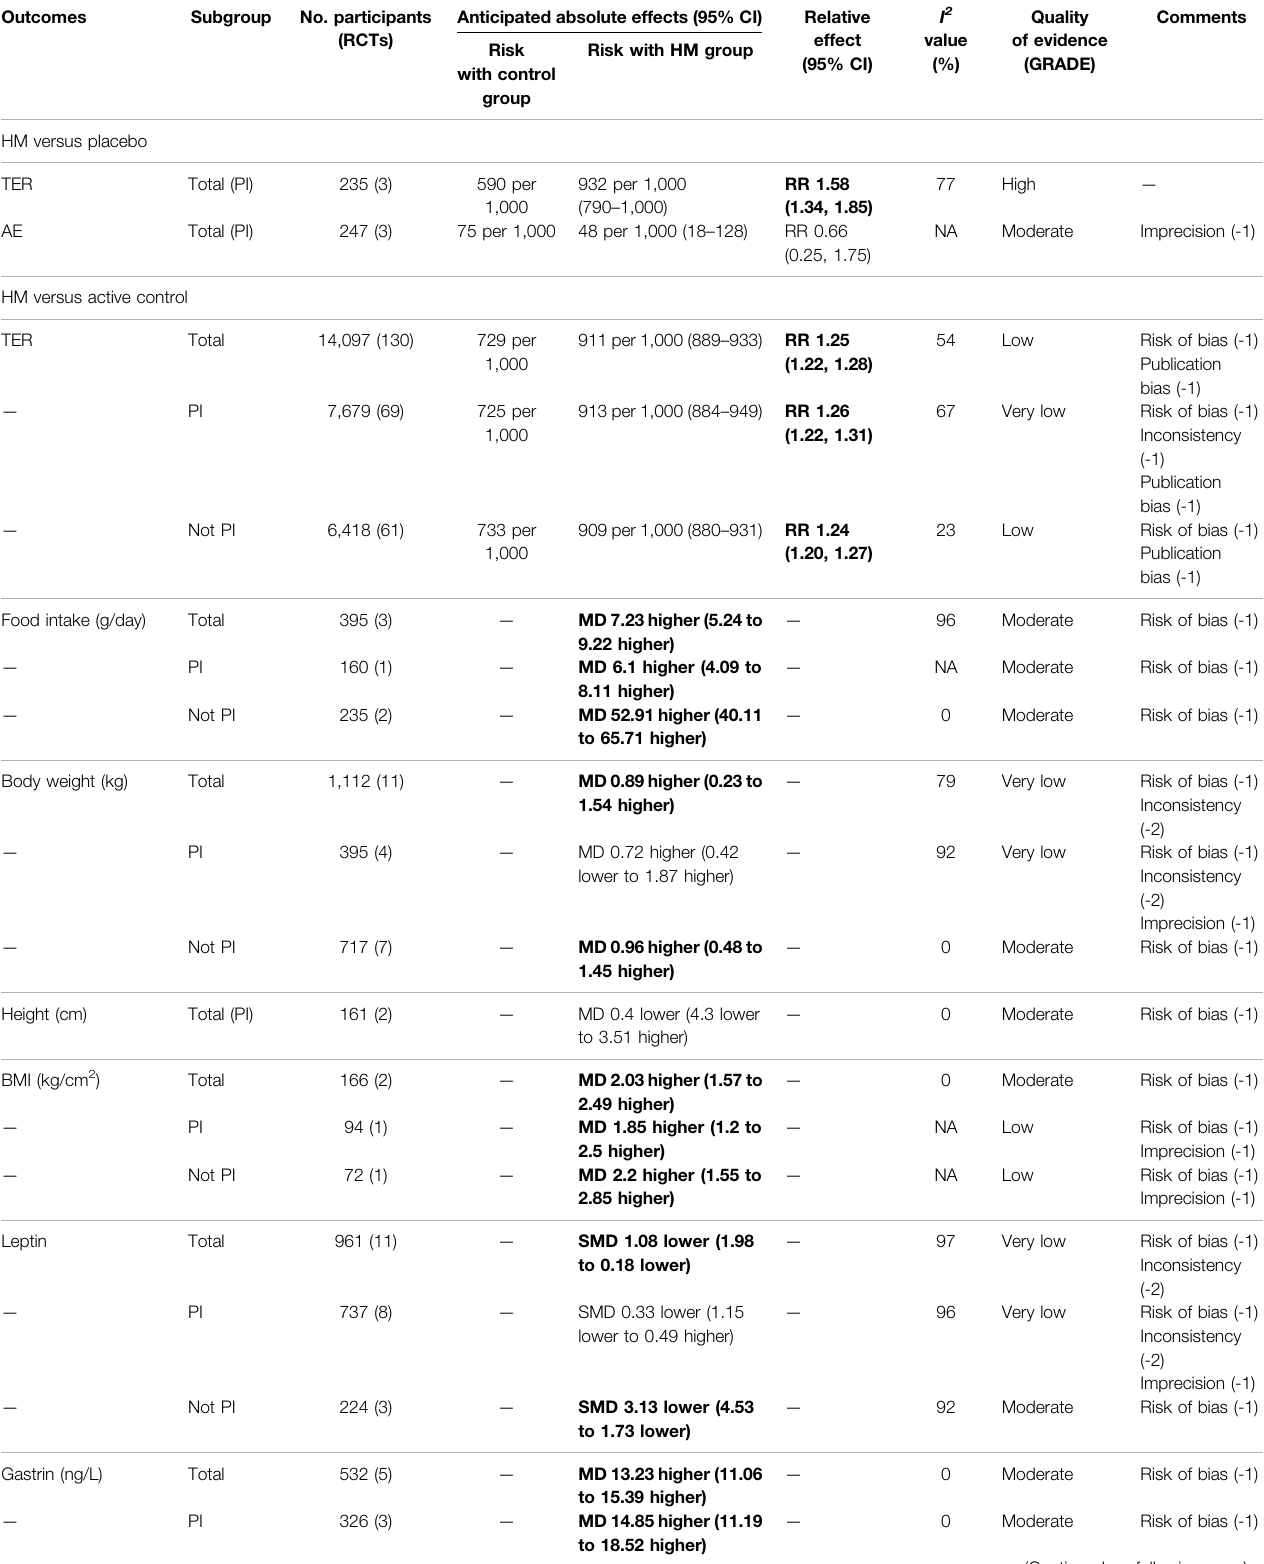
TABLE 1 | Results of meta-analysis and summary of fi